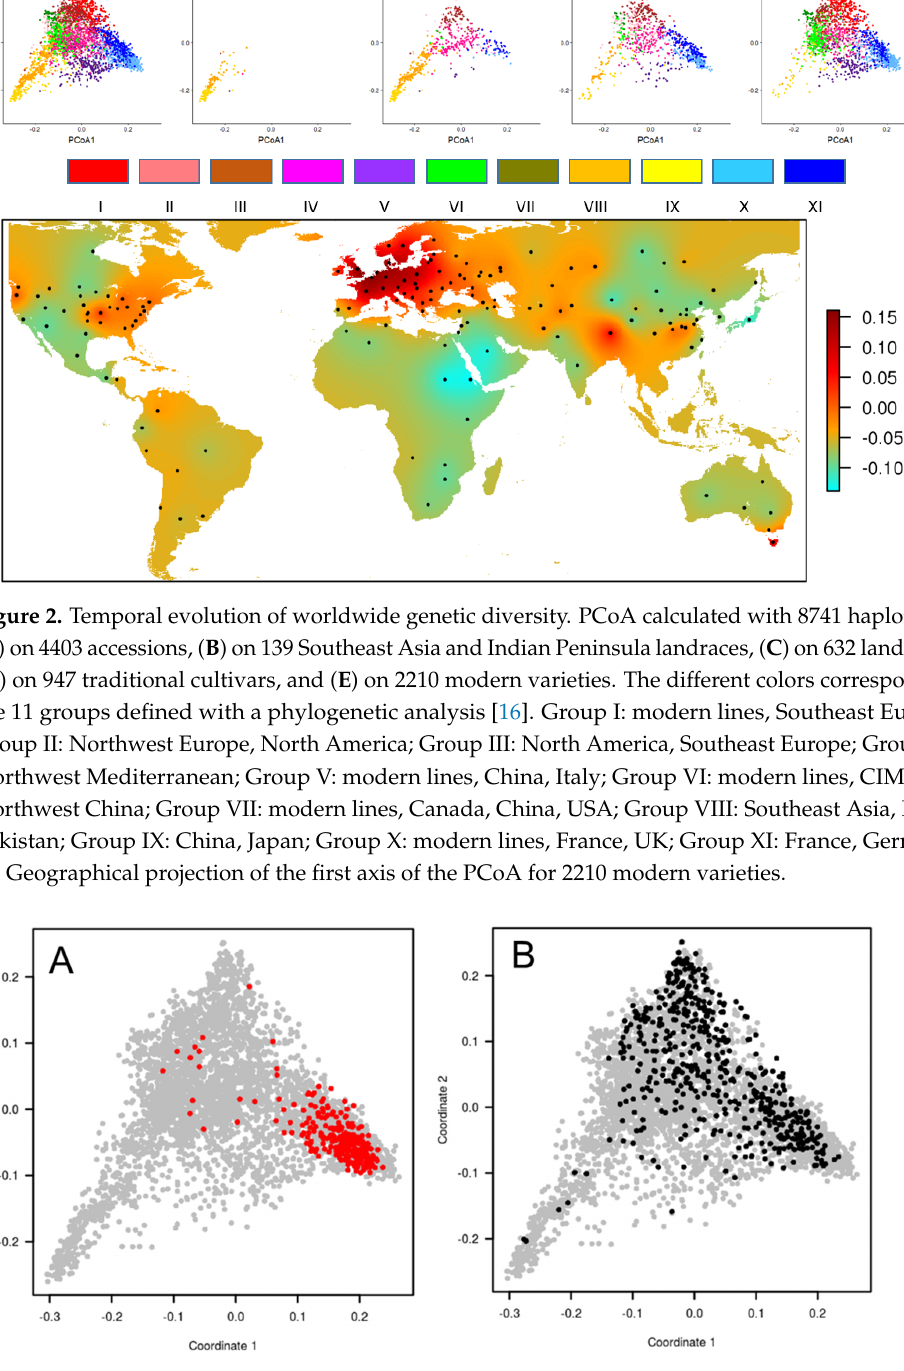
Figure 3. Principal coordinate analysis (PCoA) of bread wheat accessions calculated with TaBW410 SNP markers. ( A ) in grey, 4506 worldwide accessions of the INRAE Biological Resource Center, in red, 220 elite European winter varieties (BWP2 panel). ( B ) in grey, 4506 worldwide accessions of the INRAE Biological Resource Center, in black, a sub-sample of 450 winter wheat accessions selected based on plant height, heading date, and SNP markers, designed for association studies (BWP3 panel).